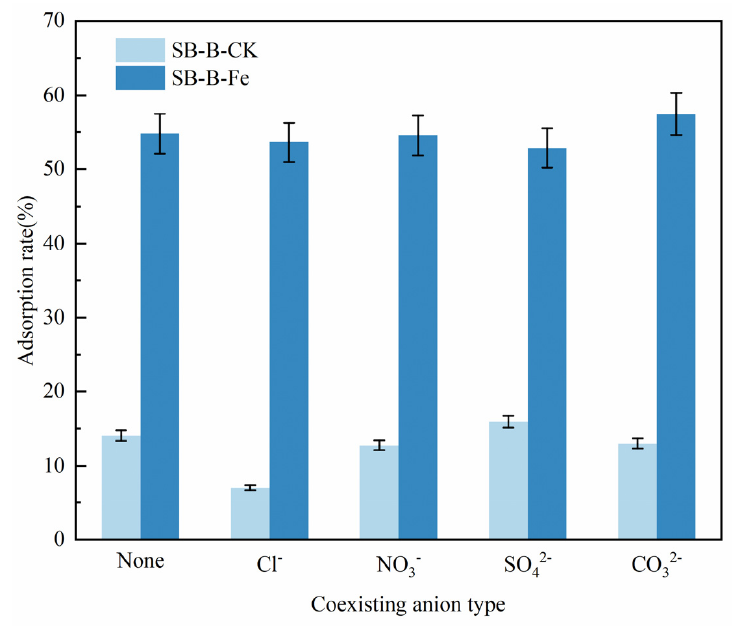
Figure 5. Effect of coexisting anions on phosphate uptake.